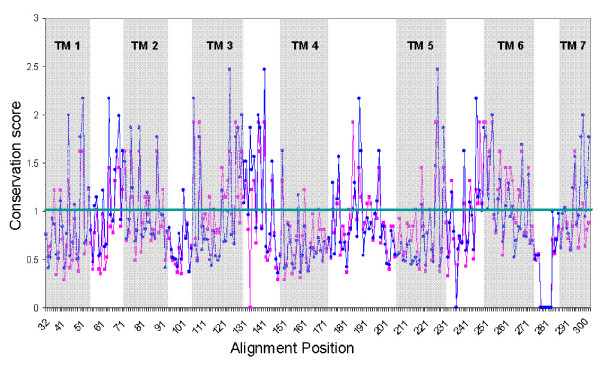
Positional conservation along OR sequences. Positions above the horizontal line are such that exceed the conservation score threshold (P < 0.05 of chi square and FDR correction) for orthologous pairs (75 positions, Pink) and for paralogous pairs (96 positions, Blue). The overlapping conservation core set includes 65 positions. The conservation scores are normalized per the statistical significance threshold for each of the two sets.